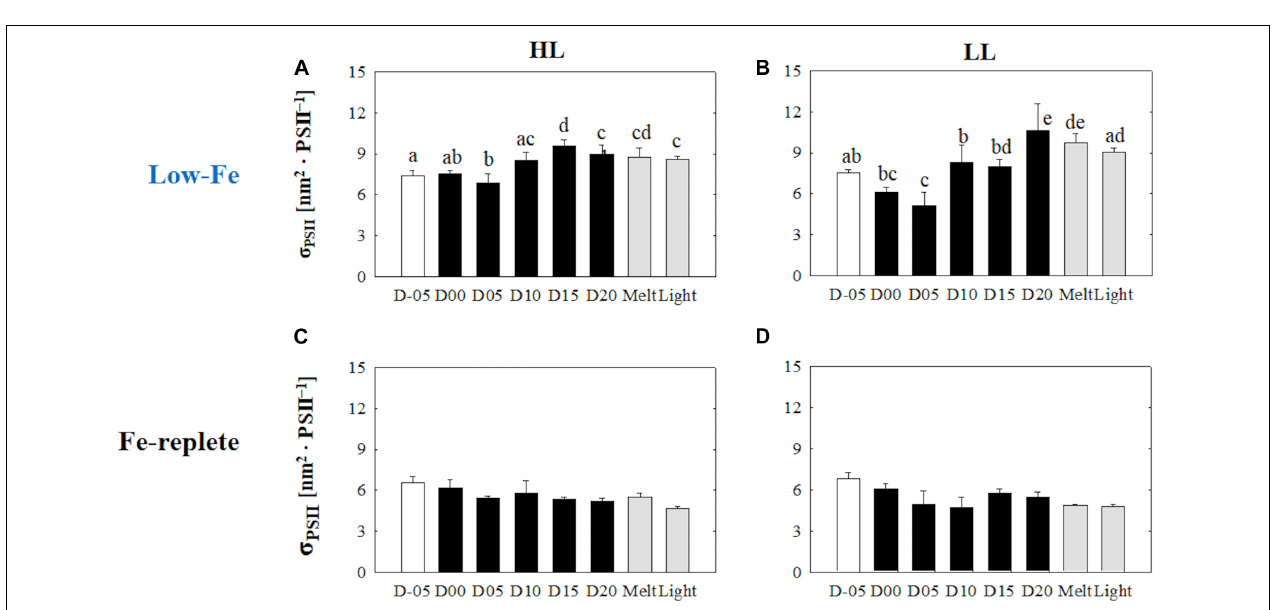
FIGURE 3 | Maximum photochemical quantum yield of PSII ( F v / F m ) at each sampling time point during the ice tank incubation experiments. Panels (A,B) show F v / F m values of the low-Fe ice tank runs in this study, whereas panels (C,D) show those of Fe-replete ice tank runs modified from Yoshida et al. (2020). Left (A,C) and right (B,D) panels indicate data from the HL and LL treatments, respectively. Open, closed, and shaded bars indicate values of pre-freeze seawater, ice, melted seawater samples, respectively. Letters above bars in a panel indicate significant differences in values between sampling days with one-way ANOVA with Tukey’s test; there is no significant difference between values if a given letter is shown in the combination of letters of the counterparts. The D stands for “day,” while Melt and Light indicate values after melting and light exposure experiments, respectively. Error bars show 1 standard deviation ( n = 6). One-way ANOVA with Tukey’s test, HL: F ( 7 , 47 ) = 57.53, p < 0.001; LL: F ( 7 , 47 ) = 55.64, p < 0.001; Two-way ANOVA test with Tukey’s test, Light: F ( 1 , 90 ) = 0.0254, p > 0.05; Day: F ( 7 , 90 ) = 24.88, p < 0.001; Light*Day: F (